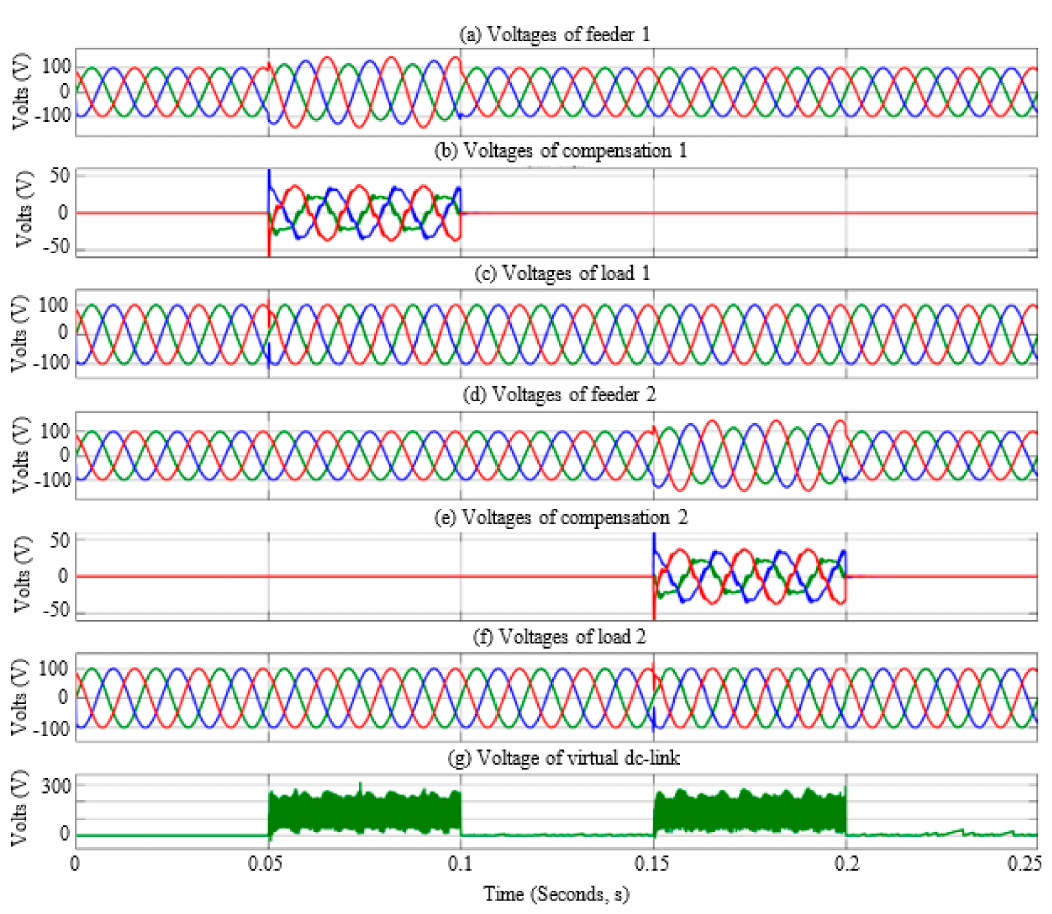
Figure 13. System waveforms in the unbalanced voltage swell compensation. ( a – c ) Waveforms of feeder 1; ( d – f ) feeder 2 waveforms; ( g ) virtual dc-link voltage